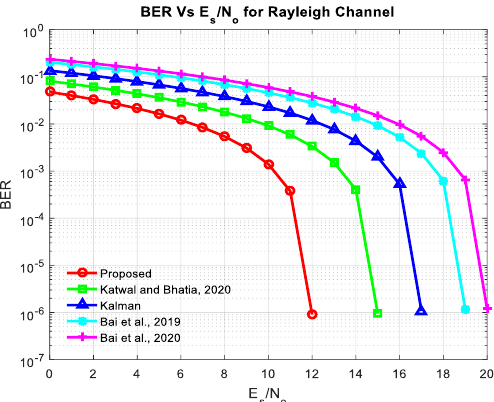
Figure 13. BER vs. E